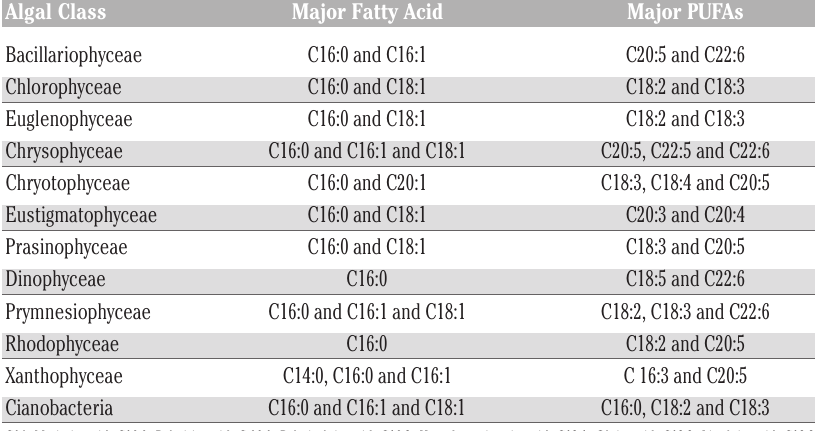
Table 1. Major fatty acid and polyunsaturated fatty acid (PUFA) in